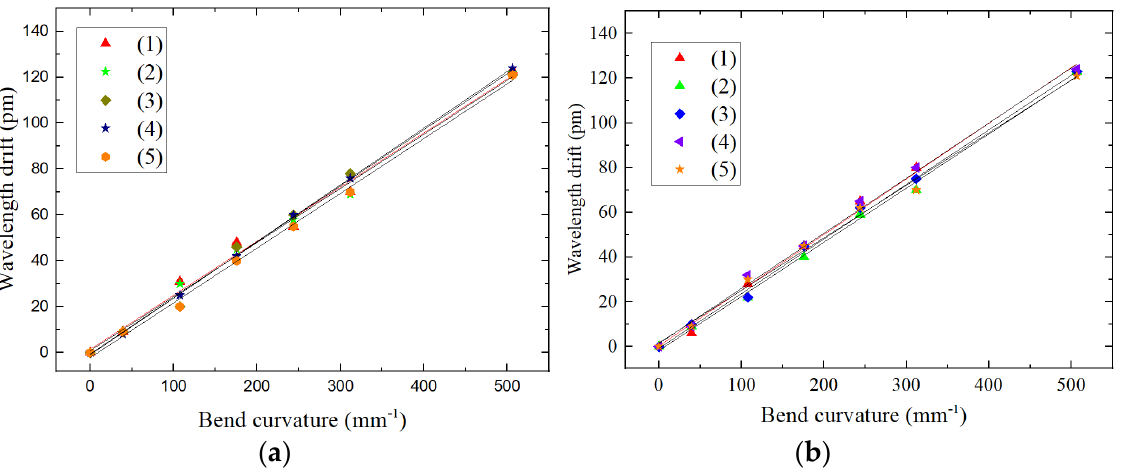
Figure 15. Shape sensor FBG error analysis of repeatability: ( a ) FBG3 center wavelength drift consistency, ( b ) FBG4 center wavelength drift consistency.